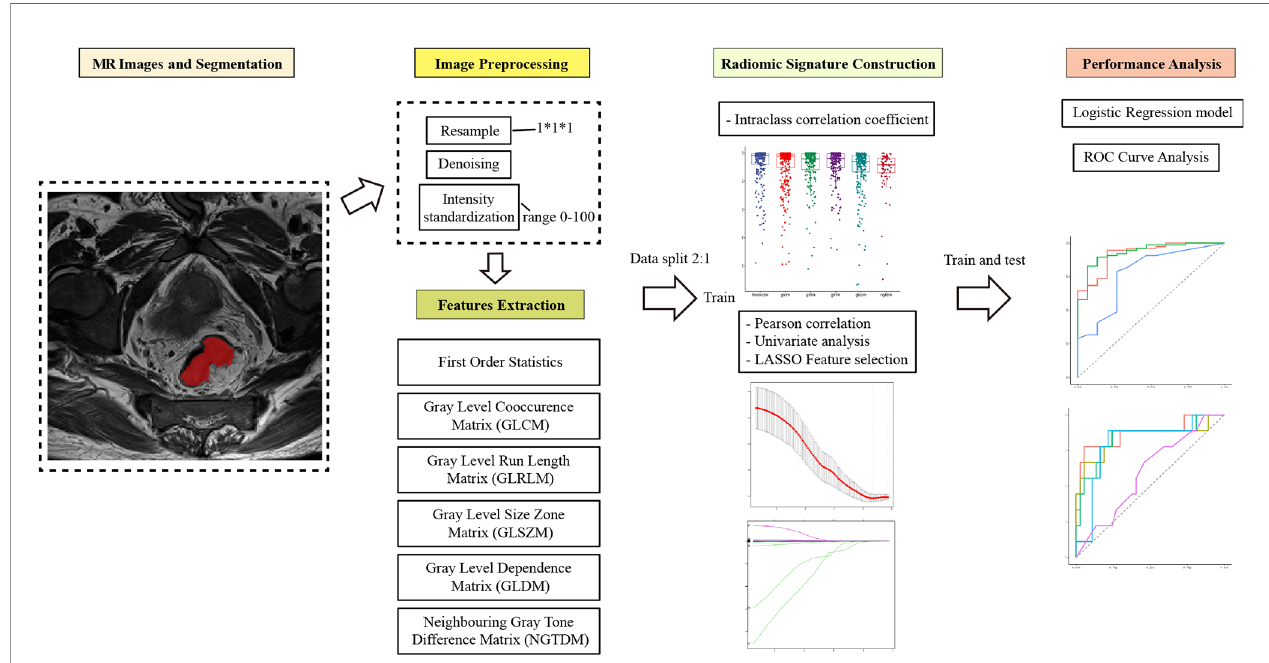
FIGURE 3 | The work fl ow of the radiomics model